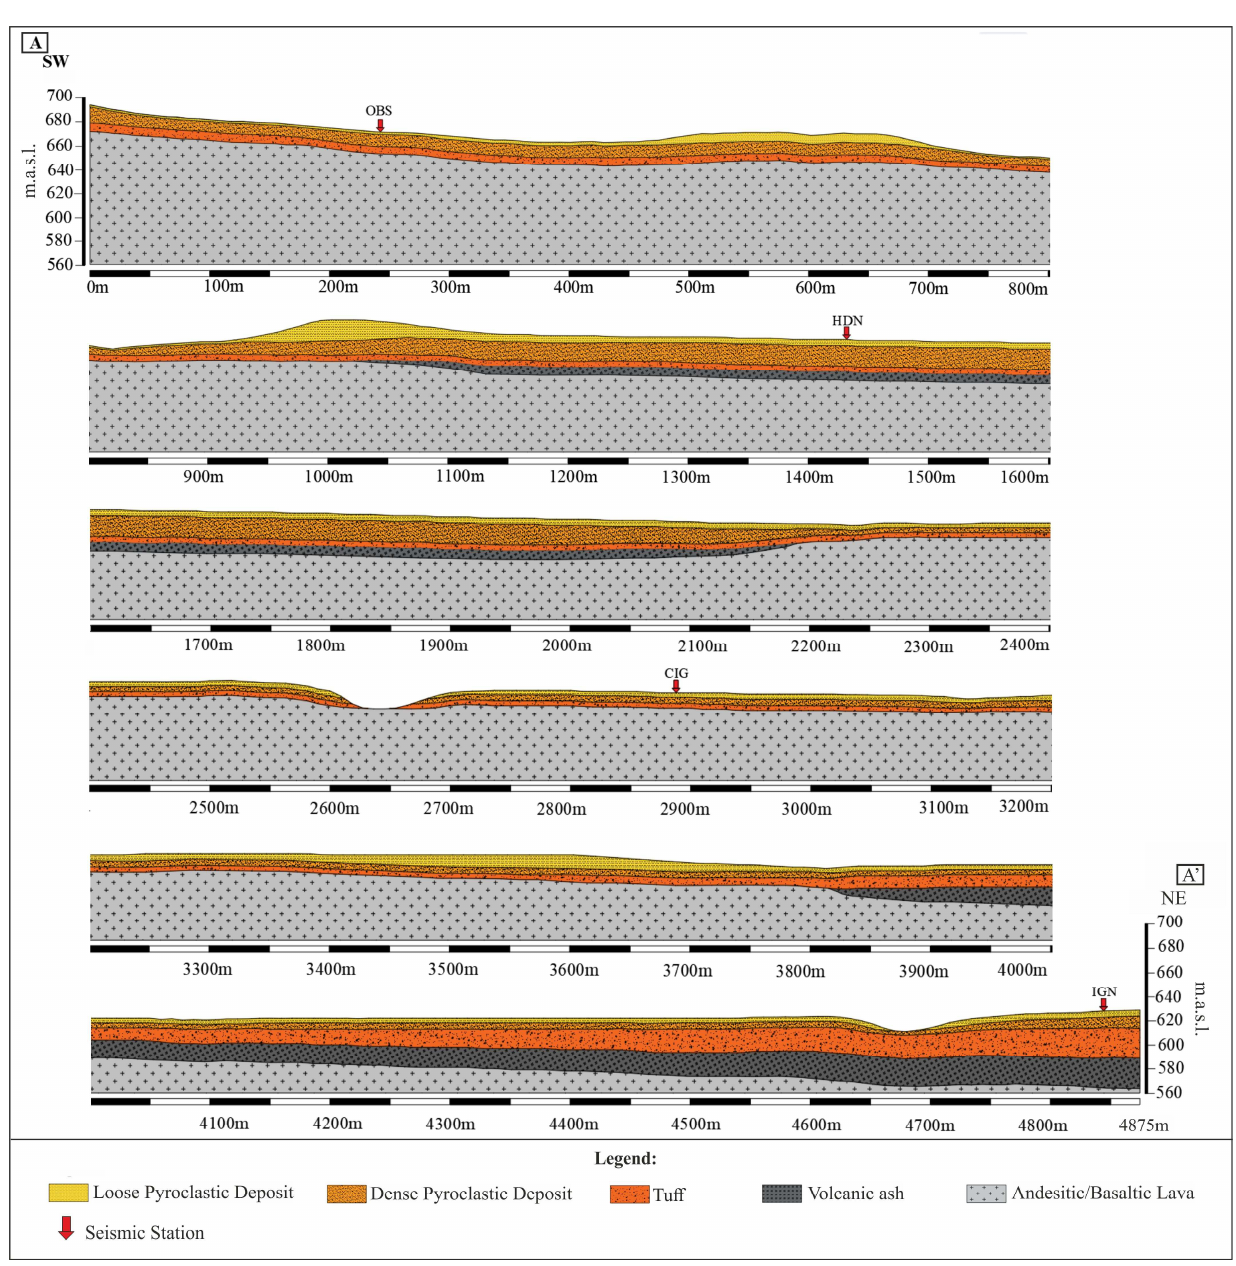
Figure 5. AA’ section of the subsoil at MASS (see Figure 3). Figure 5. AA (cid:48) section of the subsoil at MASS (see Figure